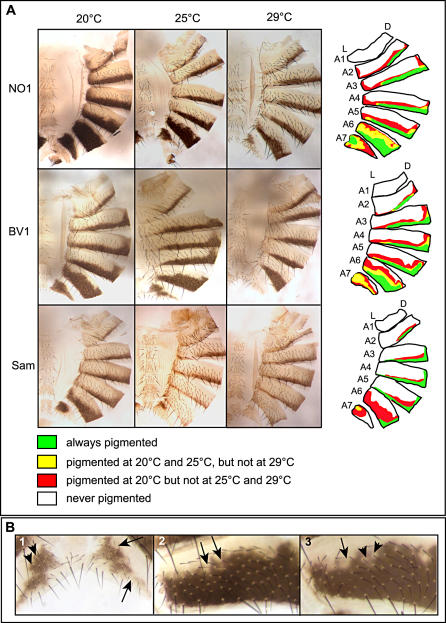
The Pattern of Abdominal Pigmentation Plasticity in Wild-Type Females(A) Abdominal phenotypes of females from the inbred wild-type lines NO1, BV1, and Samarkand grown at 20 °C, 25 °C, and 29 °C. The drawings on the right summarize the plasticity of the different regions of the body according to the color code. A1–A7, abdominal segment number; L, lateral region; D, dorsal region; SAM, Samarkand.(B) The pigmentation in wild-type females shows a variegated pattern. (1) Left and right 7th hemitergites of a BV1 female grown at 25 °C. The pigmentation is not perfectly symmetrical. White patches are visible on one side (arrows) where dark pigmentation is observed on the other side. The dark pigmentation follows the insertion of the small bristles in the inner region of the tergite (arrowheads). (2 and 3) Shows the 6th hemitergites of two NO1 females grown at 25 °C. The pigmentation patterns are very similar but not perfectly identical. The limit between the dark and yellowish regions of the tergite is not smooth but variegated. Yellowish patches (arrows) at the base of some bristles are surrounded by dark pigmentation (3, arrowheads).